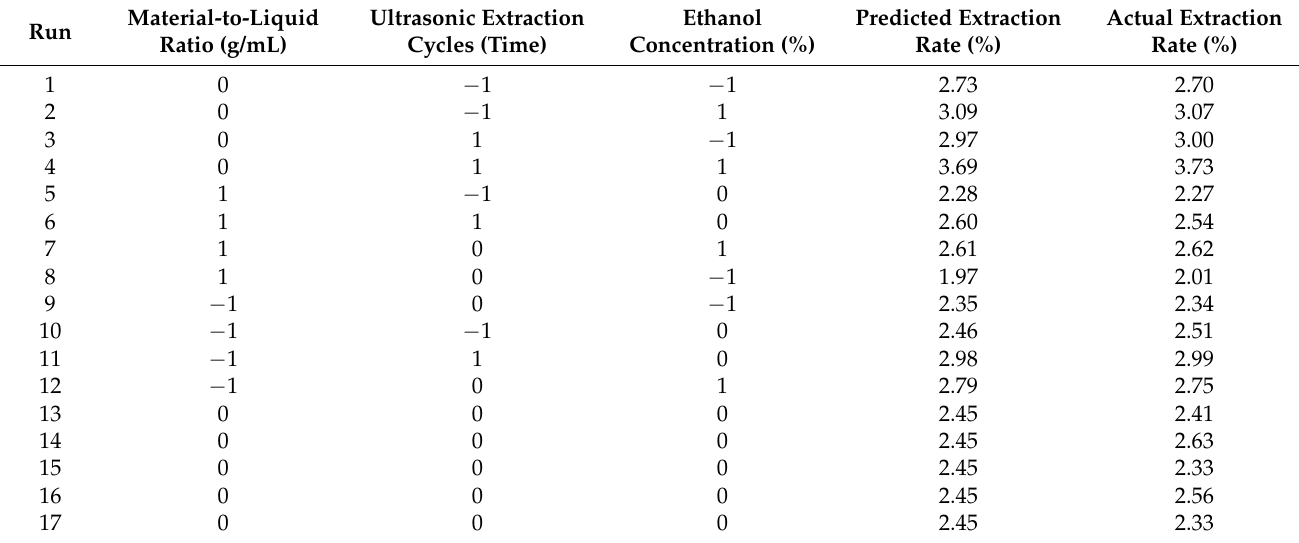
Table 3. Box-Behnken experimental design and response